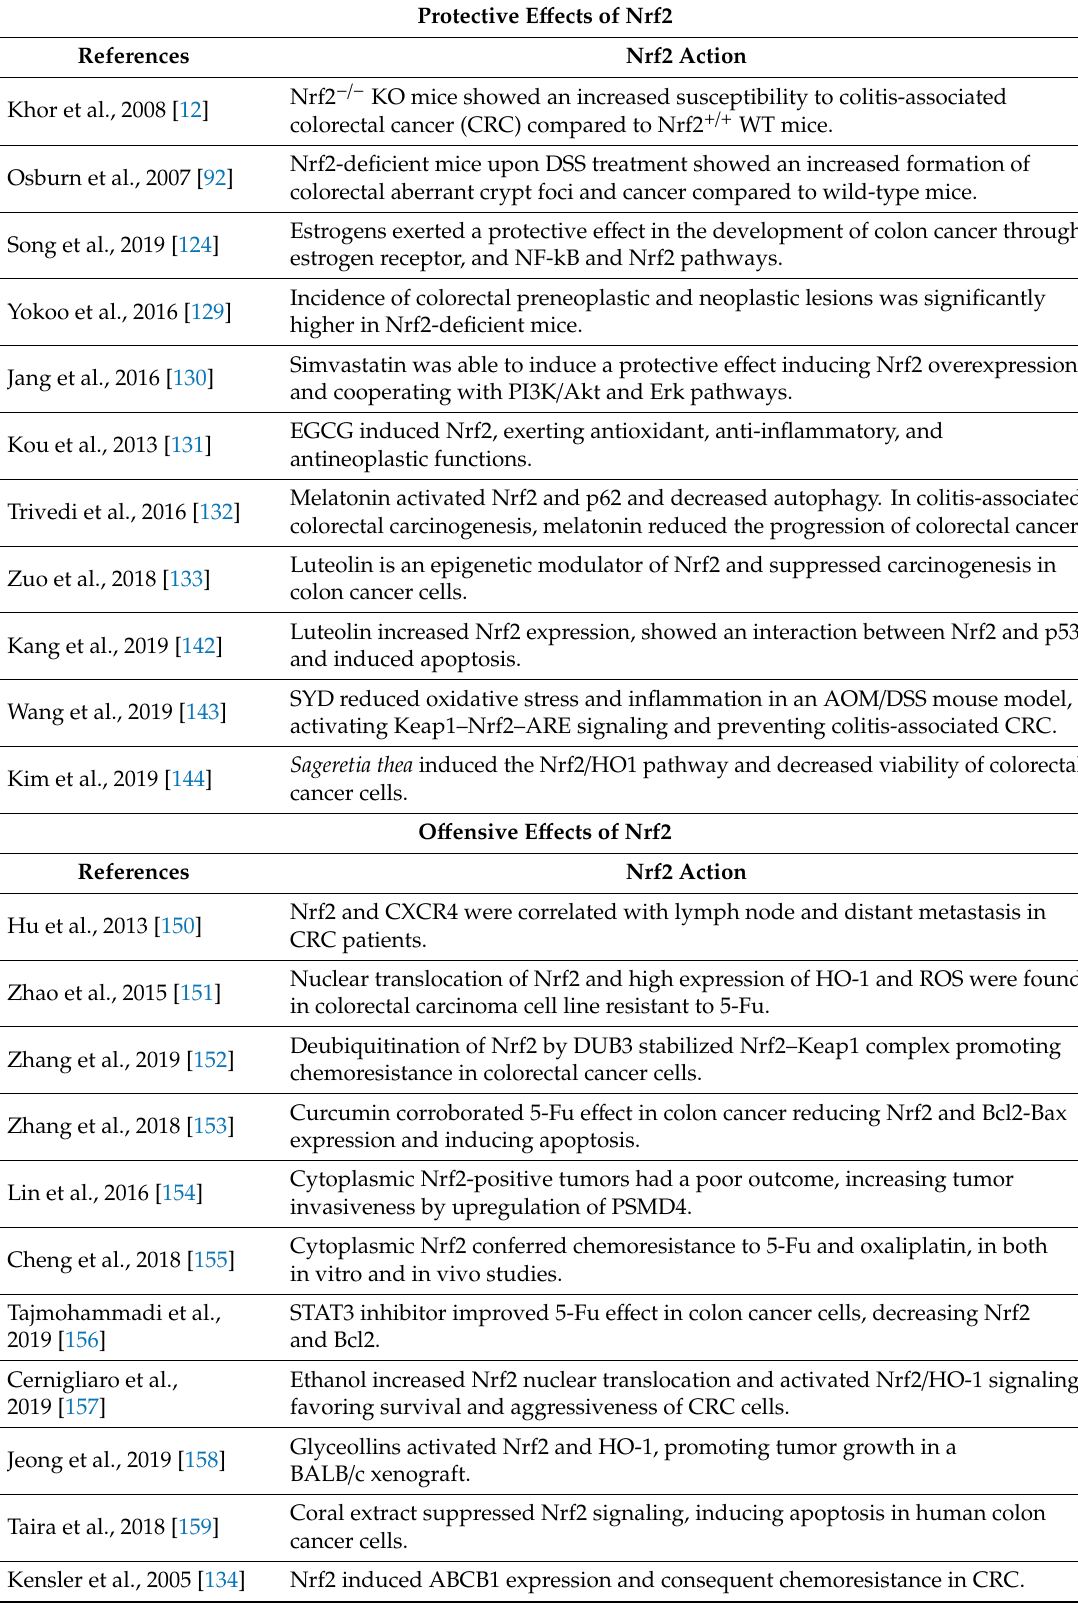
Table 4. Studies showing “protective” and “o ff ensive” e ff ects of Nrf2 in colorectal cancer. Protective E ff ects of